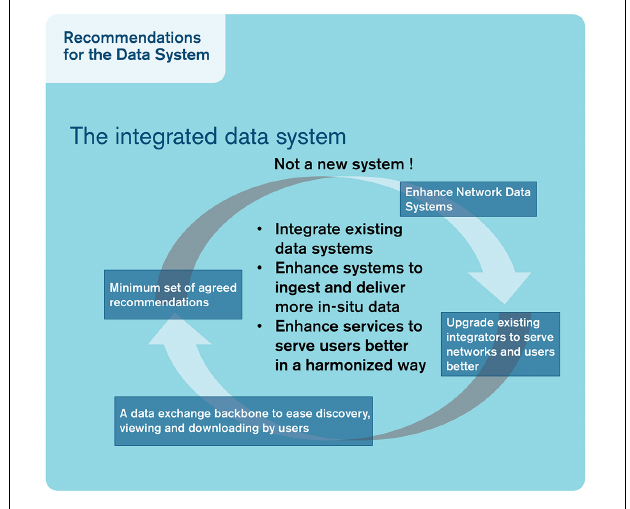
FIGURE 4 | Schematic of a view of an “integrated data system” suggested in this